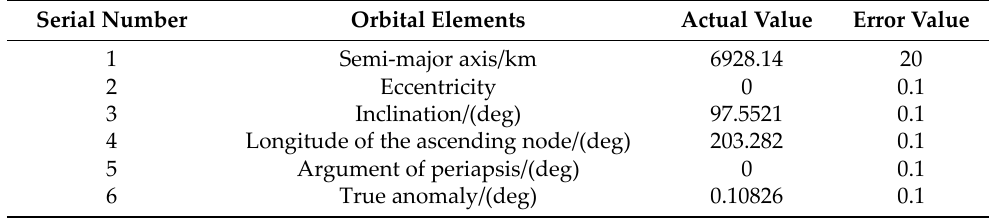
Table 1. Orbital elements of RSO in simulation.